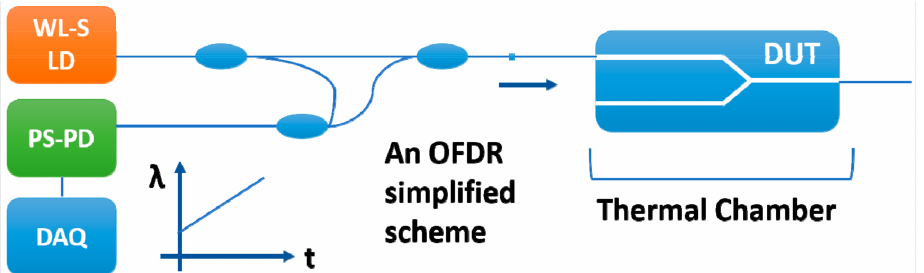
Figure 7. Reflectometric characteristics measuring scheme. (where DAQ—data acquisition unit; OFDR—optical fre- quency domain reflectometer; PS-PD—polarization-sensitive photodetectors; WL-S LD—wavelength-sweeping laser diode; DUT—device under test; λ —radiation wavelength;